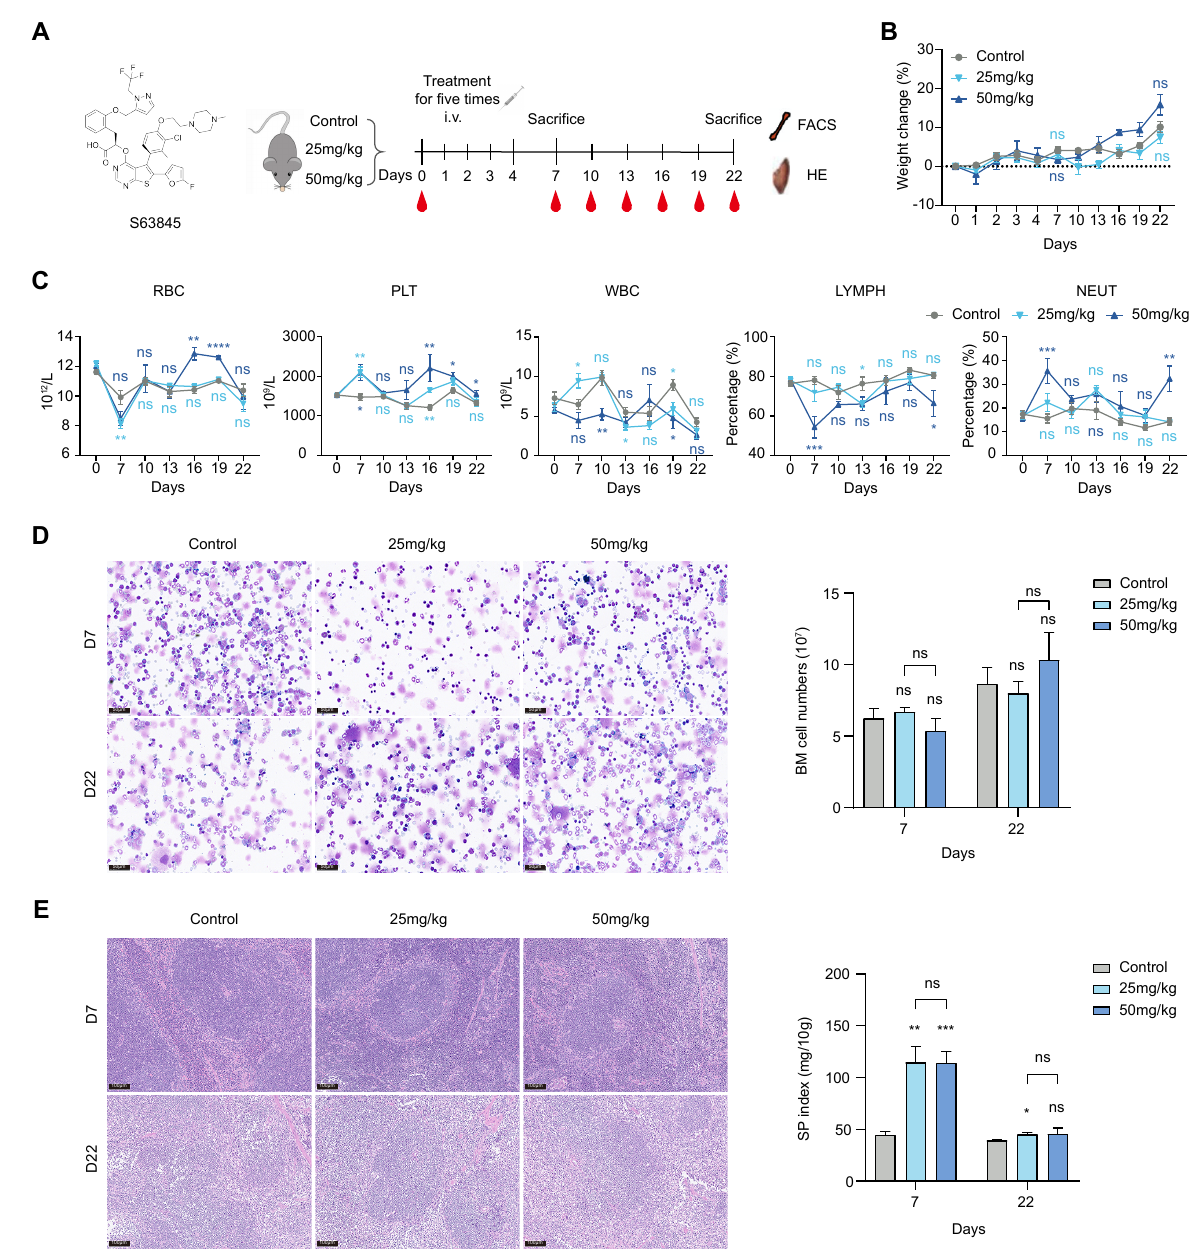
Figure 1. Effect of S63845 treatment on the hematopoiesis of CB6F1 mice. ( A ) Schematic representa- tion of S63845-treated hematopoietic suppression in CB6F1 mice and the chemical structure of S63845. ( B ) Body weight change after S63845 treatment of CB6F1 mice. n ≥ 4 mice per group. ( C ) Chronolog- ical change in peripheral blood cells after S63845 treatment of CB6F1 mice. n ≥ 4 mice per group. ( D ) Representative BM Wright–Giemsa-stained smears ( left ) and complete BM counts ( right )